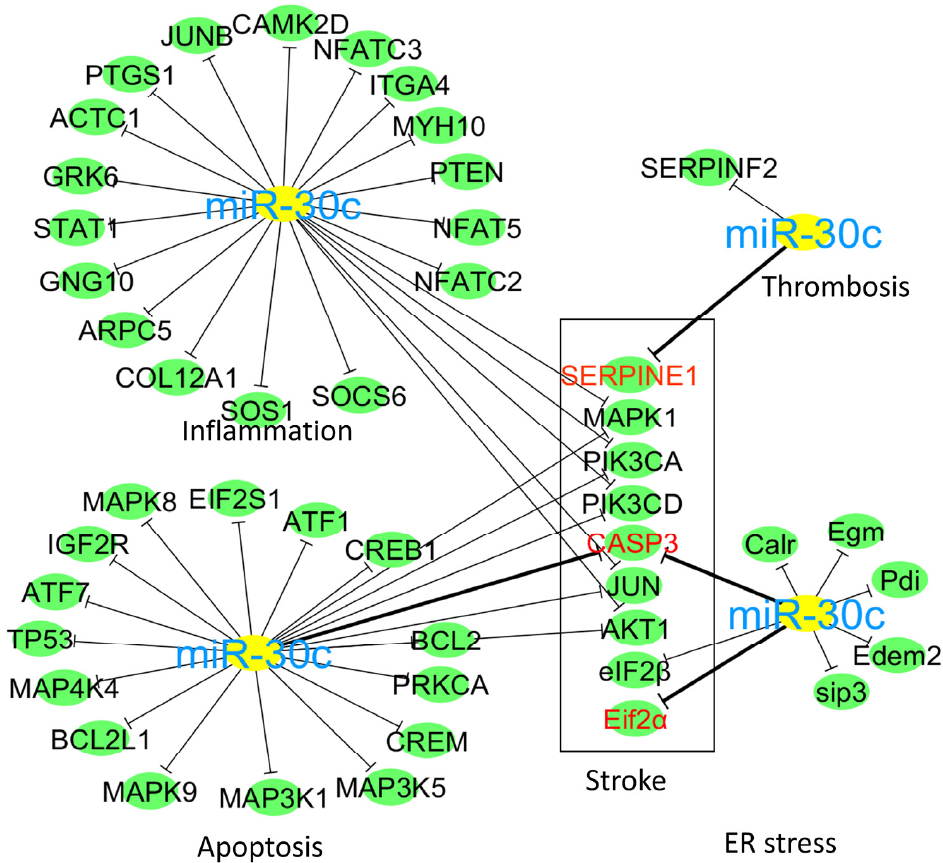
Figure 6. Prediction of miR-30c target genes. The green nodes are the predictive interactive genes of miR-30c involved in thrombosis, inflammation, ER stress, and apoptosis pathways, and the red nodes are the selected target genes common with neurological disease.